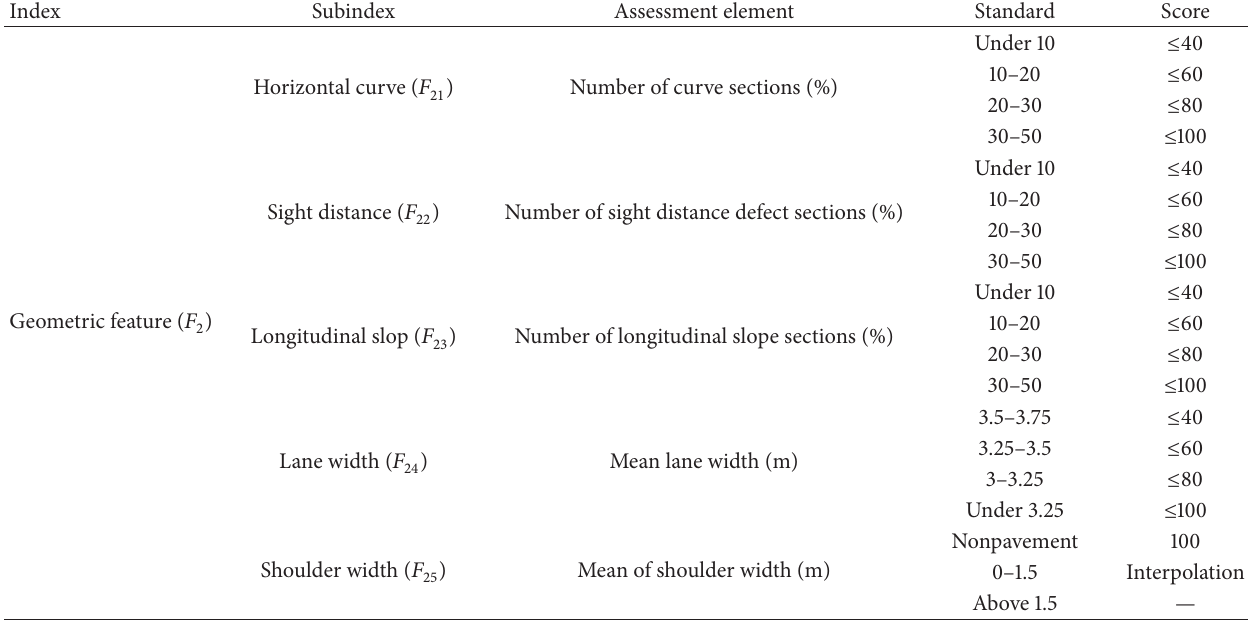
Table 12: Calculation and scoring method according to assessment items.